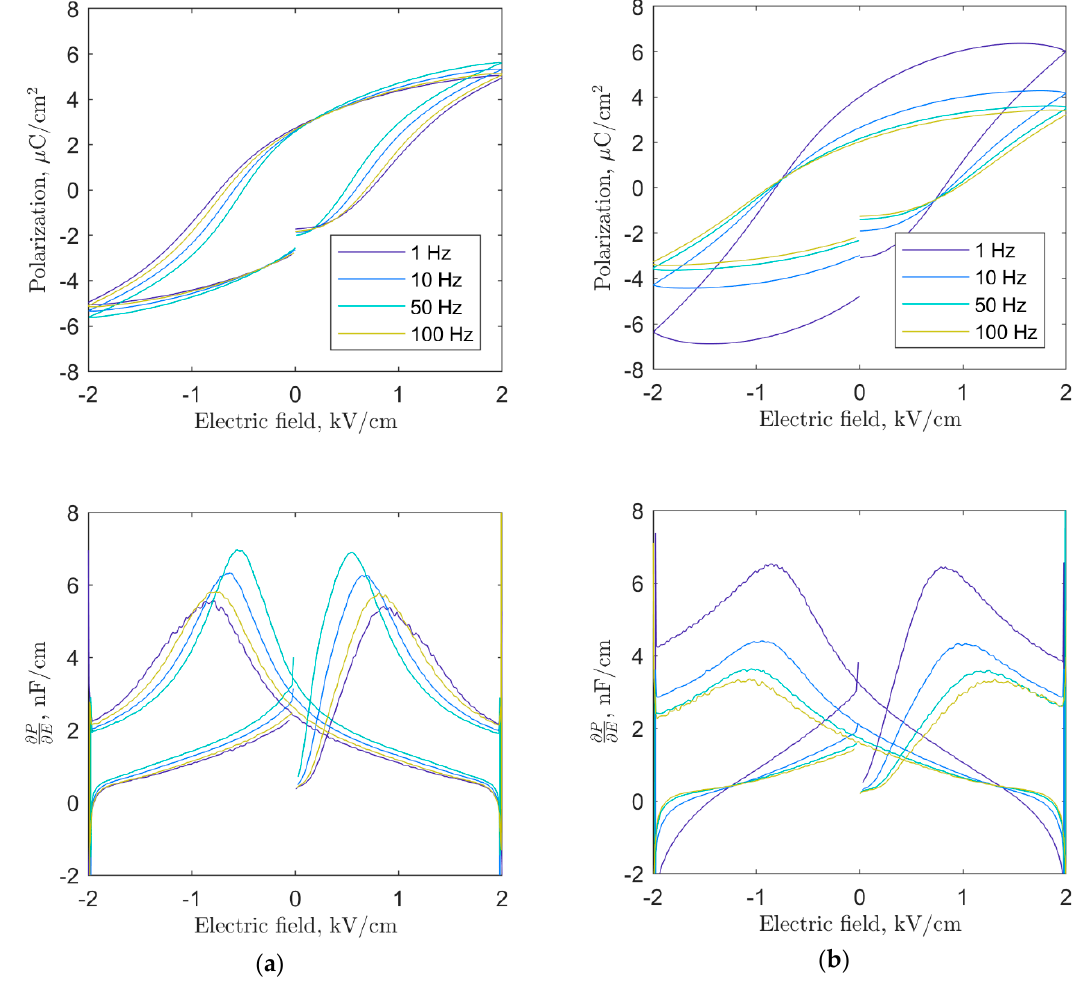
Figure 3. Ferroelectric hysteresis loop and current versus electric field for SBN 33 annealed at ( a ) 800 °C and ( b ) 1350 °C.